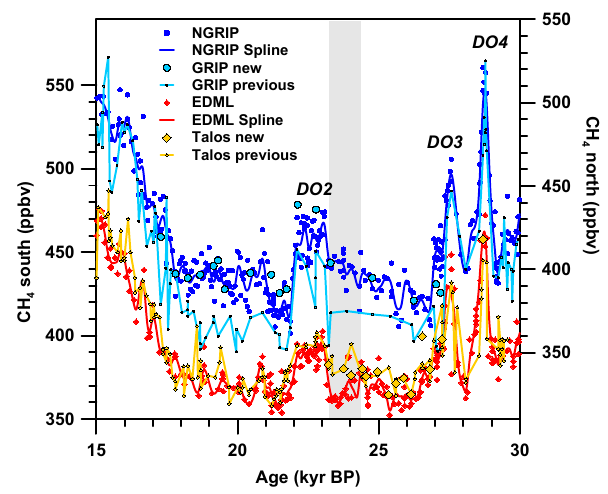
Fig. 2. Remeasurements along the GRIP and TALDICE ice cores. For clarity reasons, data from Greenland (circles) and Antarctica (diamonds) are shown on different concentration axes. The NGRIP (blue, Schilt et al. (2010b) and new data) and EDML (red, EPICA Community Members (2006) and new data) data are the same as in Fig. 1. Additionally plotted are the previous GRIP record (Blunier et al., 1998; D¨allenbach et al., 2000) (light blue) and the TALDICE record (Buiron et al., 2011; Stenni et al., 2011) (yellow). New GRIP and TALDICE remeasurements are shown as big light blue and yel- low symbols, respectively. The grey shaded area marks the time in- terval, where the EDML record deviates from the TALDICE record. All CH 4 concentrations are synchronised to the unified EDML gas age scale derived by Lemieux-Dudon et al.